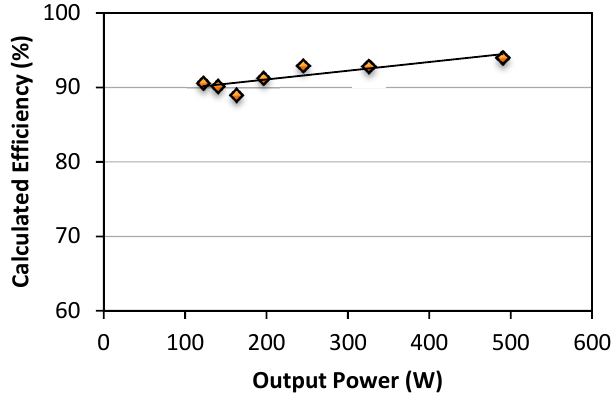
Figure 18. Calculated efficiency curve for the converter at variable loads